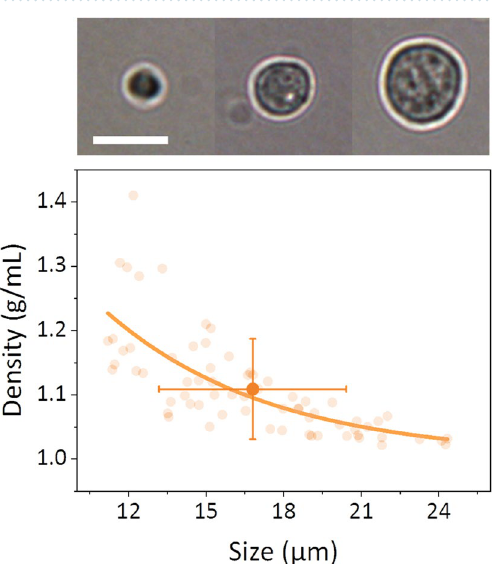
Figure 4. Multiparametric particle spectrometry . ( a ) Schematics of the particle length measuring principle. Up. Electric field distribution for the particle passing under the laser spot at different positions (1–3). Down. Mechanical (blue line) and optical (red line) signal expected for this particle. ( b ) Up. Particle size distribution measured for a sample of 67 PMMA particles and 192 Silica particles. Down. Particle size distribution measured by SEM images inspection. ( c ) Left. 3D scatter plot (particle velocity, frequency shift and reflectivity change). Right. 2D projections for the mixture of PMMA and silica particles being flown at 100 mbar.